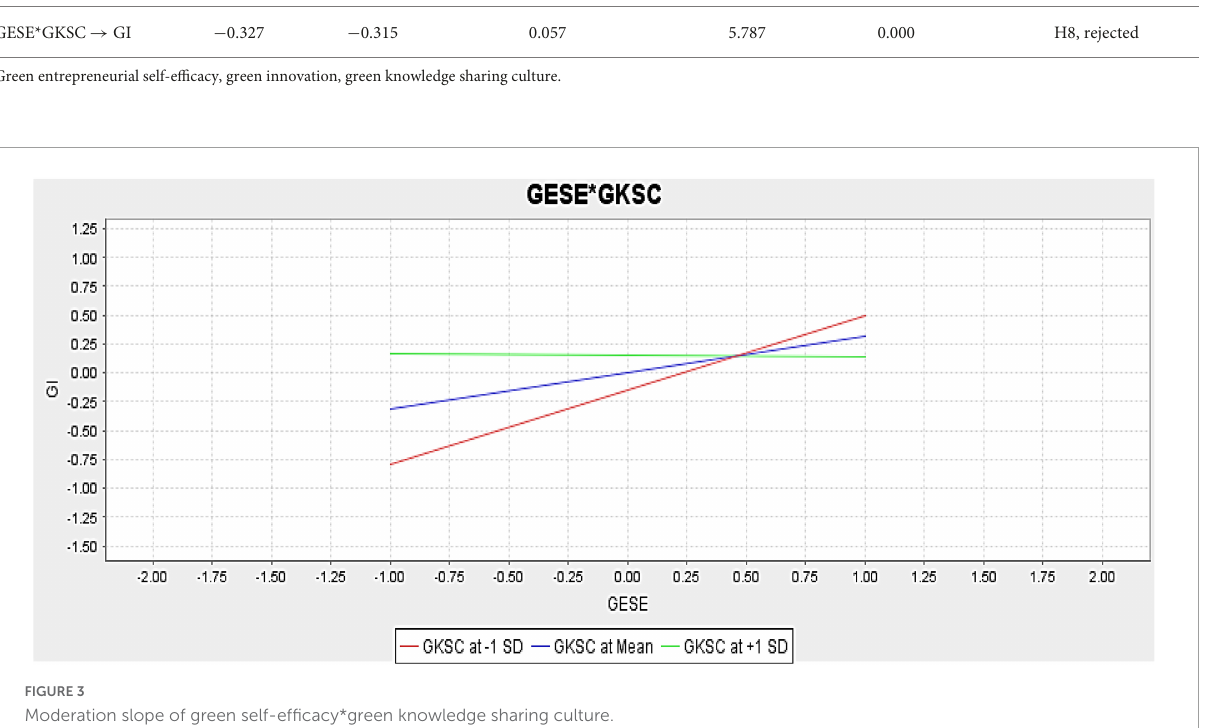
boost productivity and offset growing raw material